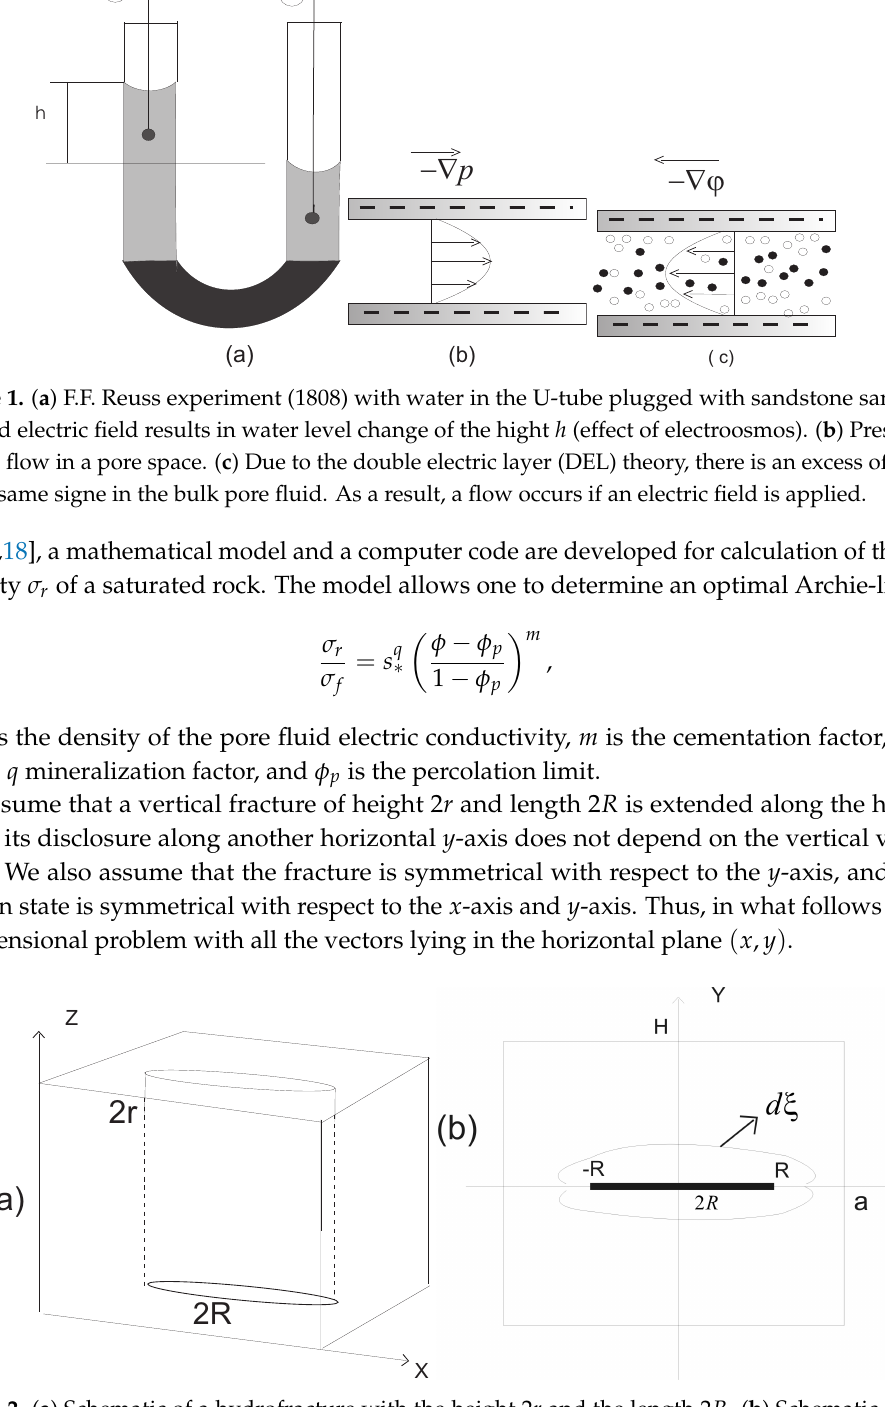
Figure 2. ( a ) Schematic of a hydrofracture with the height 2 r and the length 2 R . ( b ) Schematic of an invasion front near the fracture when it is associated with its footprint interval ( − R , R )